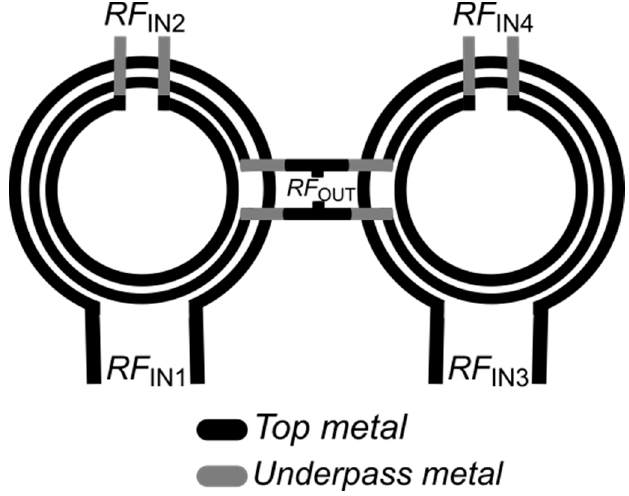
Figure 10. Example of a series–parallel-combining transformer (SPCT) for 4 PA voltage–current combining.